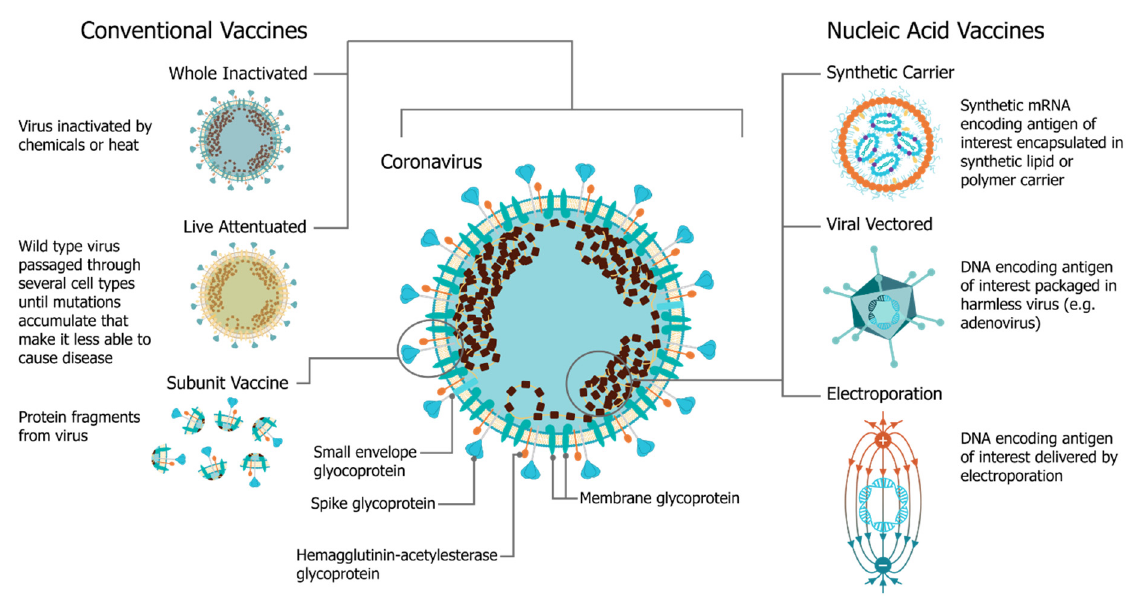
Figure 1. A comparison of vaccine platforms including vaccines derived from the virus itself and are formulated as a part or whole modified version of the virus ( left ) and nucleic acid vaccines, such as self ‐ amplifying RNA vaccines ( right ). Nucleic acid vaccines are derived from knowledge of the viral genome, where glycoproteins are encoded into nucleic acids and delivered with either a synthetic carrier such as a lipid nanoparticle or an inert viral delivery system such as adenoviruses. The encoded antigen sequences are then expressed by the host cells. Table 1. Published preclinical and clinical trial data with mRNA COVID ‐ 19 vaccines.